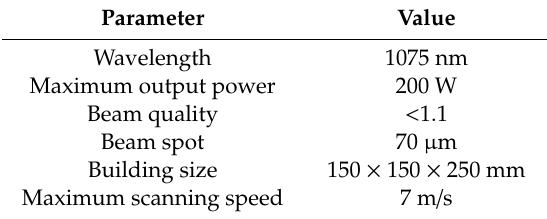
Figure 3. ( a ) SEM image of pure aluminum powder particles, ( b ) powder particle size distribution, and ( c ) laser scanning strategy. Table 1. Technical parameters of the selective laser melting (SLM) MetalSys 150.